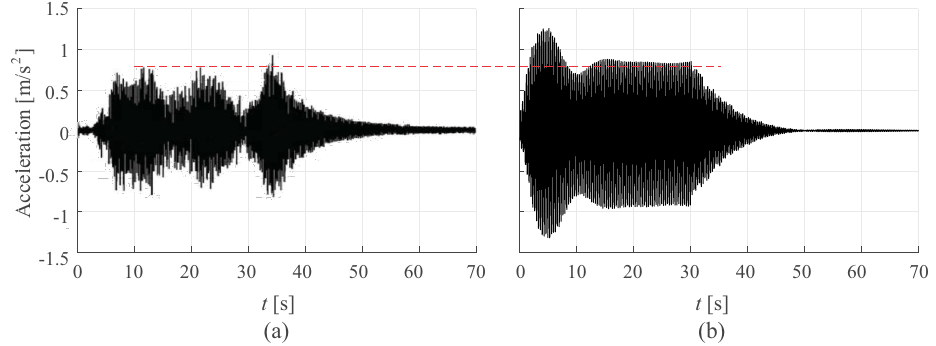
Figure 14. Comparison between time history of experimental (after [20]) ( a ) and numerical ( b ) verti- cal acceleration.